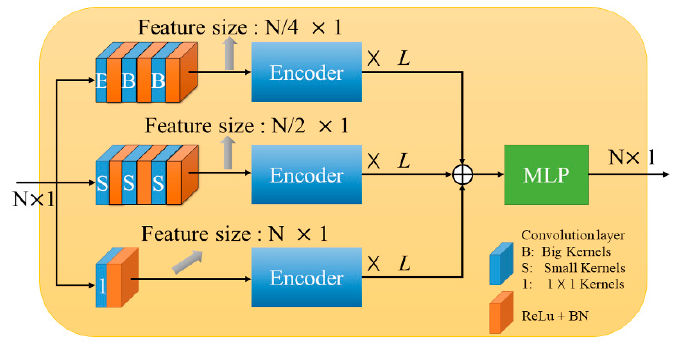
Figure 4. The architecture of the improved Transformer.